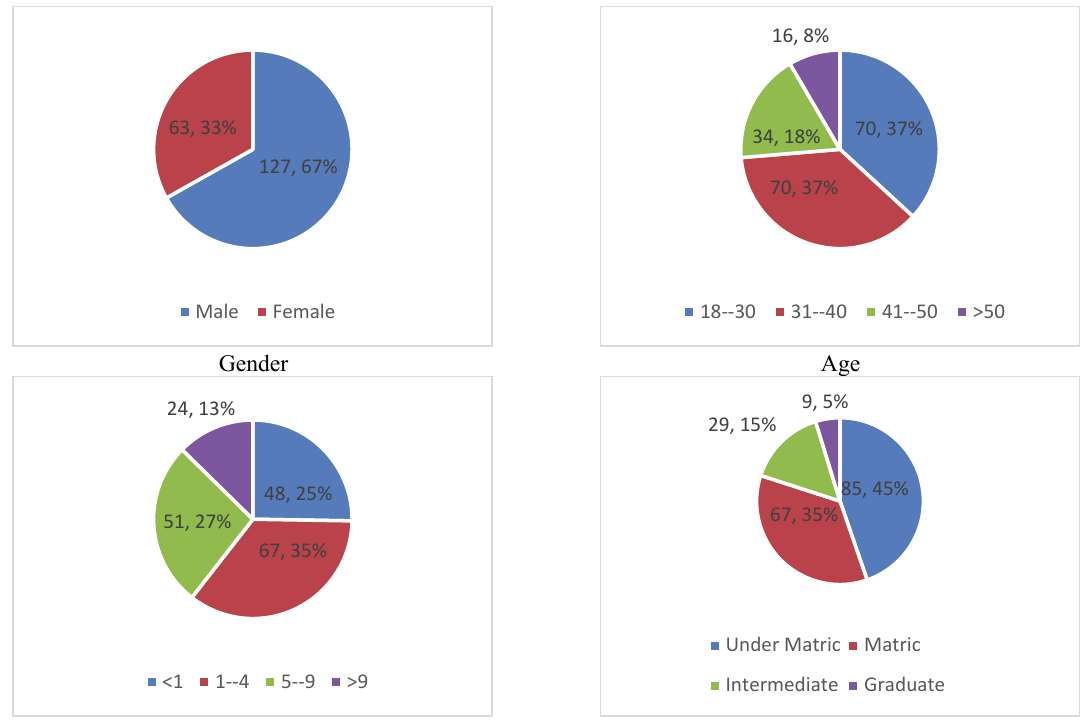
Fig. 2. Demographic data of the